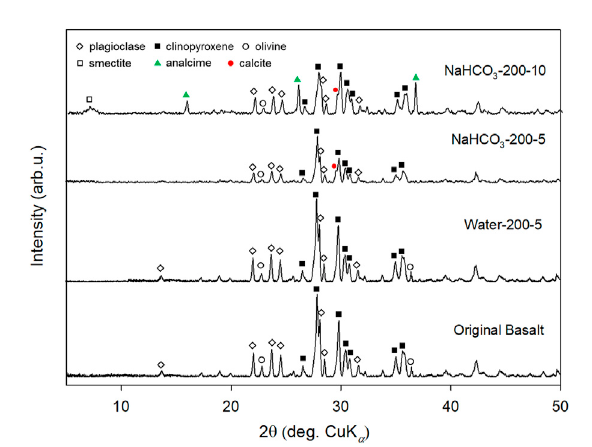
FIGURE 3 XRD patterns of original basalt and solid materials collected